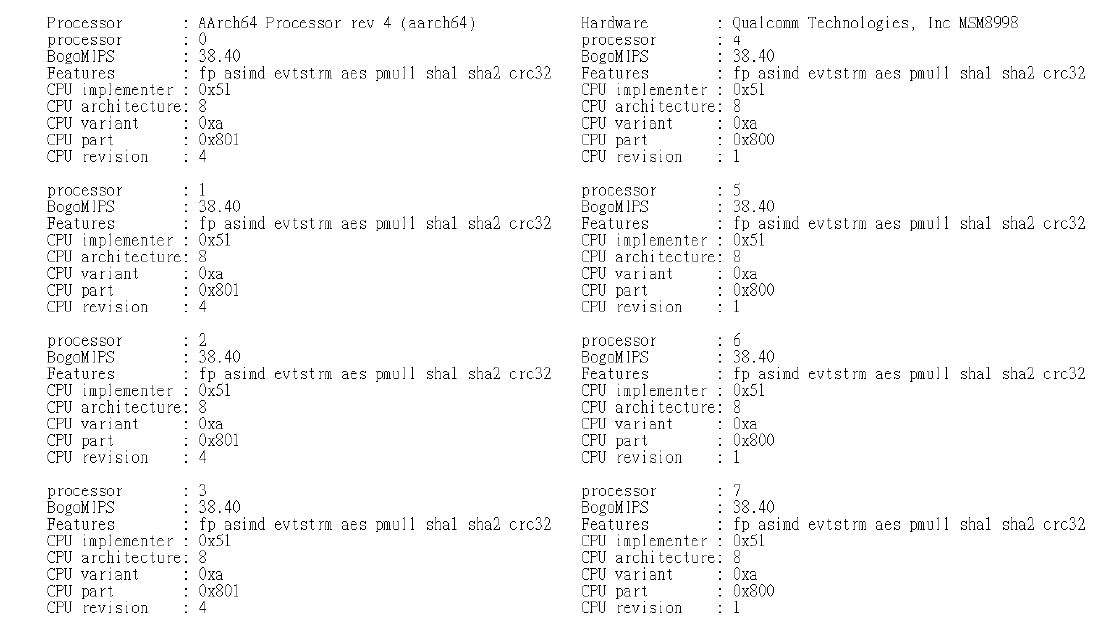
Figure 12. This is the information of CPU.